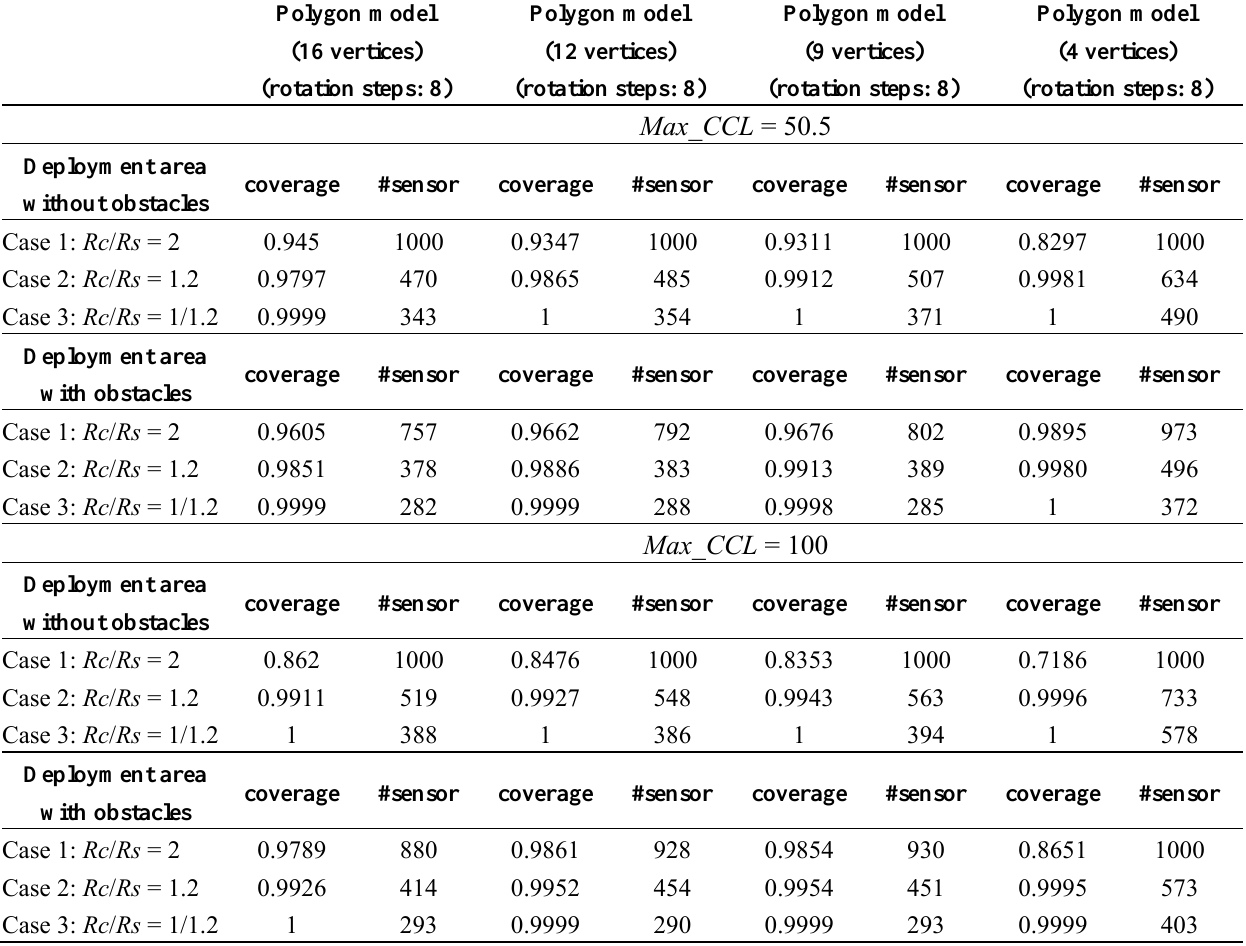
Table 10. The sensing coverage rates and the usage of sensor nodes under fixed values of Max_CCL in Simulation